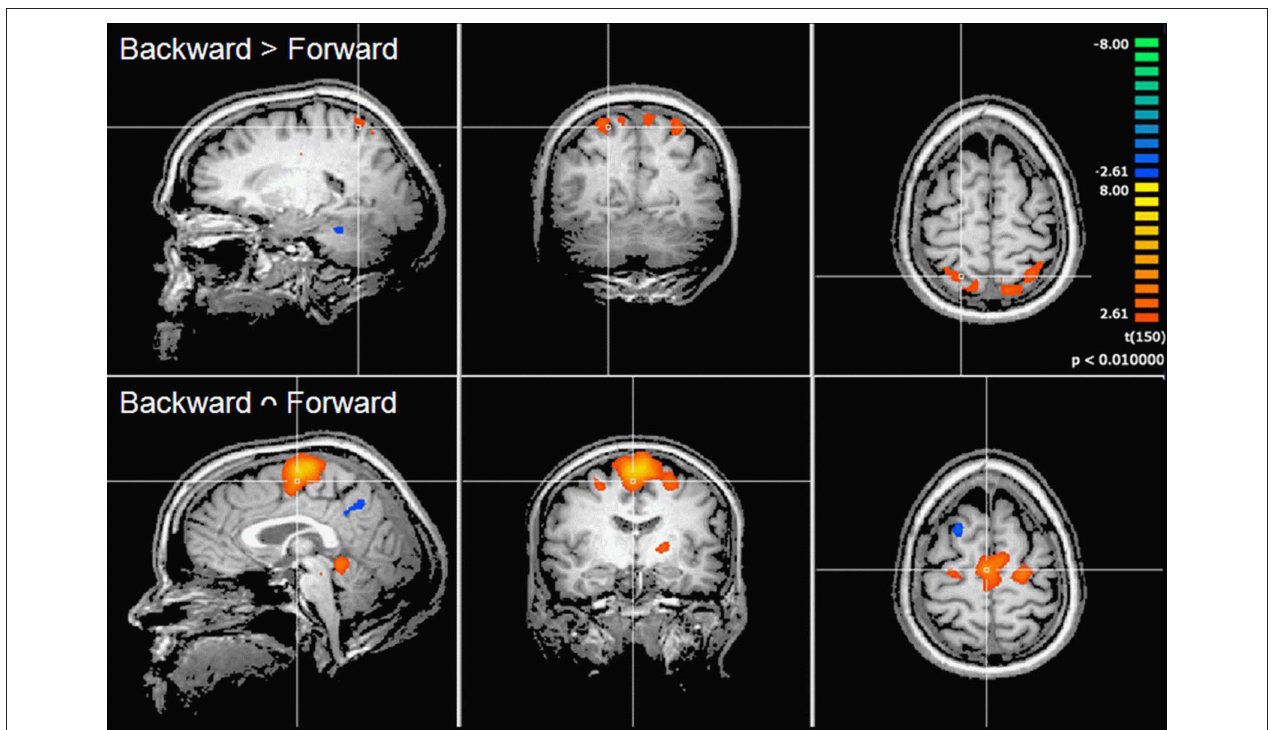
FIguRe 2 | Cortical activations during motor imagery overlaid on example anatomical slices from one individual. Upper panel: contrast of backward versus forward walking with yellow to orange indicating backward > forward and blue to green indicating forward > backward (cf. Table 3 ). Lower